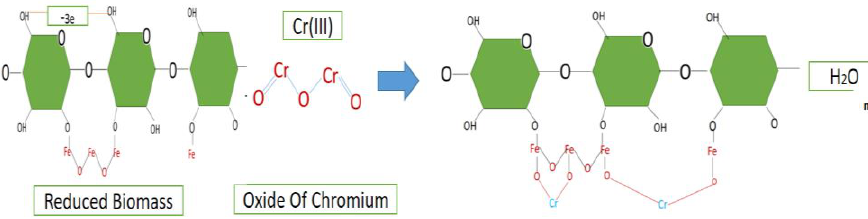
Figure 6. Representation of Cr (VI) adsorption. Table 4. Physicochemical characterization of the ECFe sample after treatment.